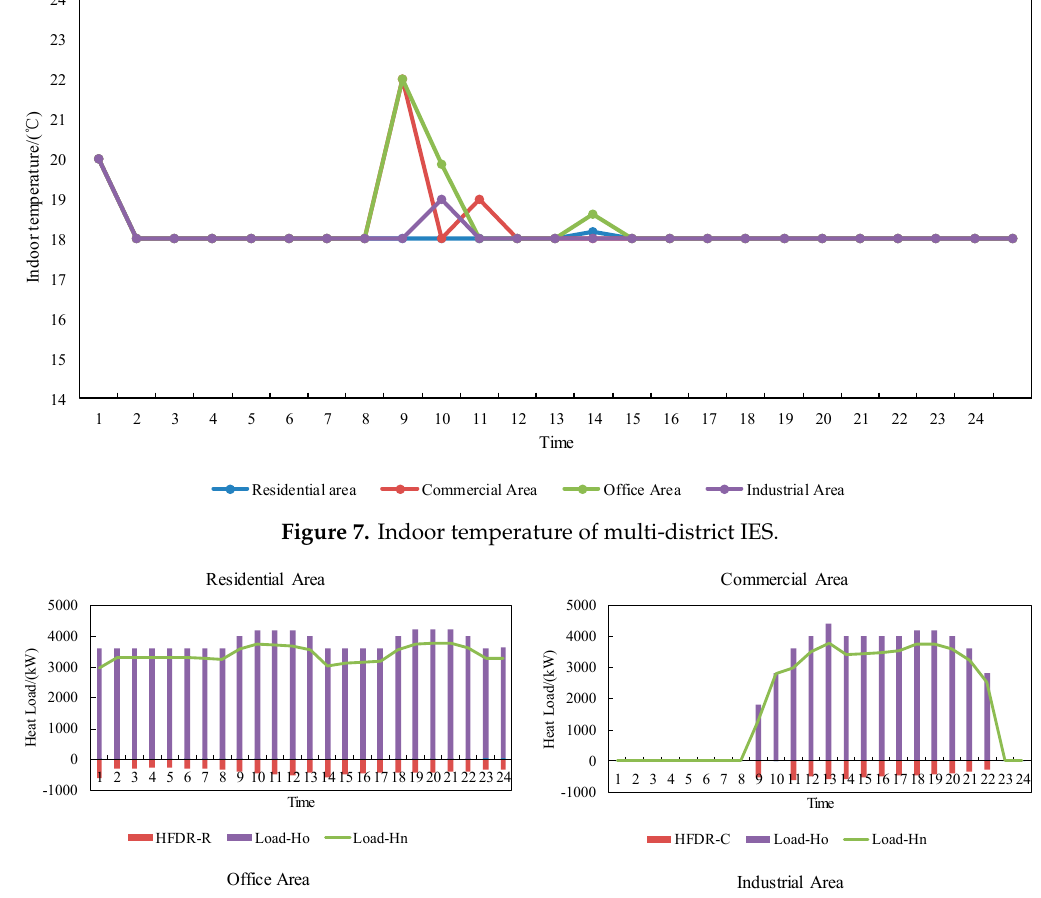
Figure 8. Adjustment situation of heating load after FDR of thermal load.